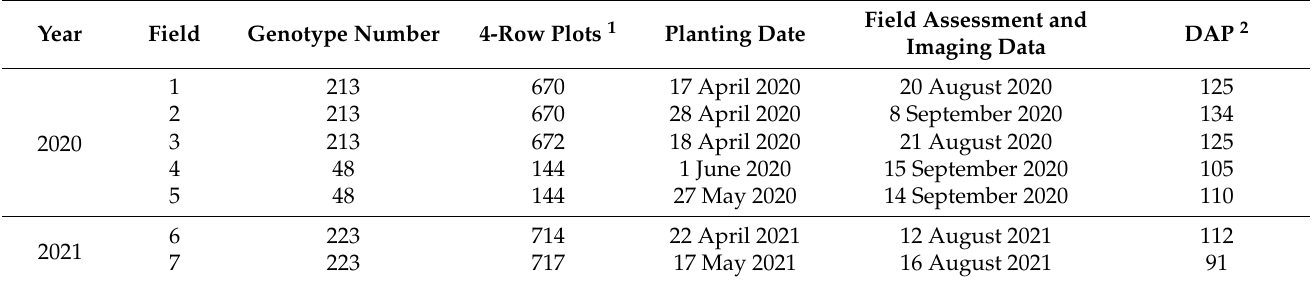
Table 1. Summary of field experiments and data collection in 2020 and